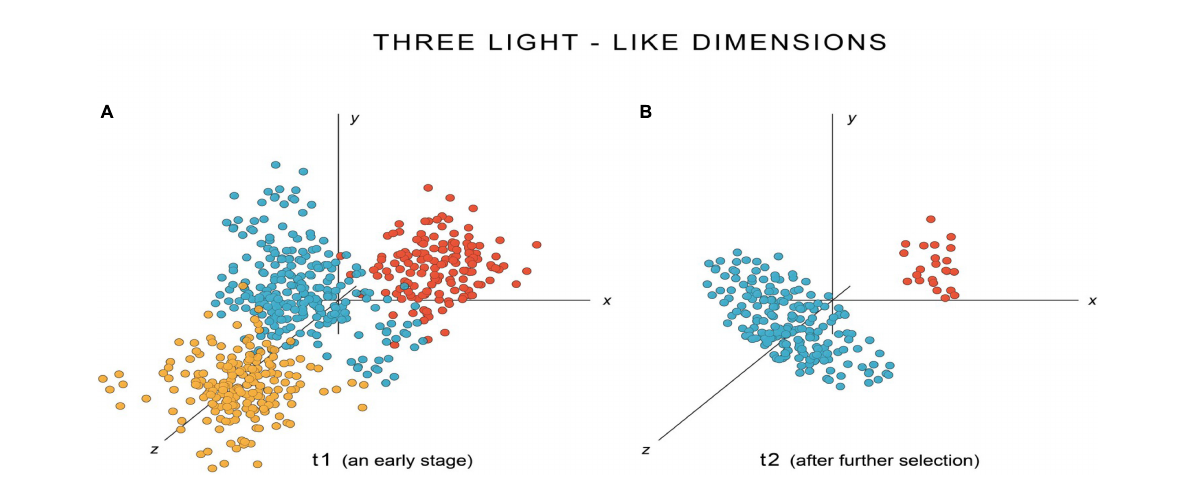
FIGURE3 Evolving point clouds in a large dimensional version of E-space, showing three of those dimensions ( x , y and z ) that, for the sake of argument, are assumed here to map light-like experiential properties. There are of course many other dimensions that cannot be shown, and the ur-experience of light could well evoke points in those other dimensions, just as point clouds for other modalities might initially intrude, as shown here, into light-like dimensions. (A) Shows an early stage in the evolutionary process for a species for which consciousness is newly emergent from the preconscious condition, and (B) a later stage, after natural selection has had an opportunity to further refine that emergent set of experiences. The point clouds evoked in response to light stimuli are shown in blue, and those for two other modalities represented in xyz space in this hypothetical example, sound and odor, in orange and red, respectively. Through selection, evolution will progressively eliminate SCs evoking experiences that are maladaptive for each sensory modality, so in (B) point clouds evoked by stimuli other than light will have either been eliminated from these three light-like dimensions, as in the case of acoustic experience (the orange point cloud has vanished), or will be in the process of being eliminated, as here for olfactory experience (the now much smaller red point cloud). The point cloud for light experience, meanwhile, has become more compact so as to form a disc with white light at the center, as in the previous